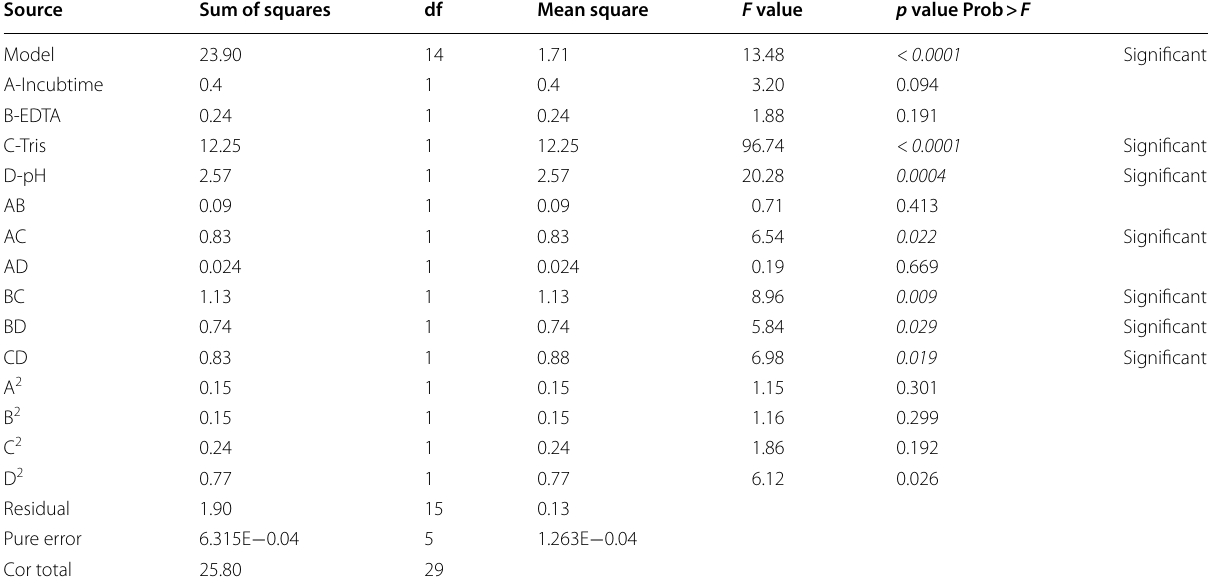
Table 3 ANOVA for response surface quadratic model Source Sum of